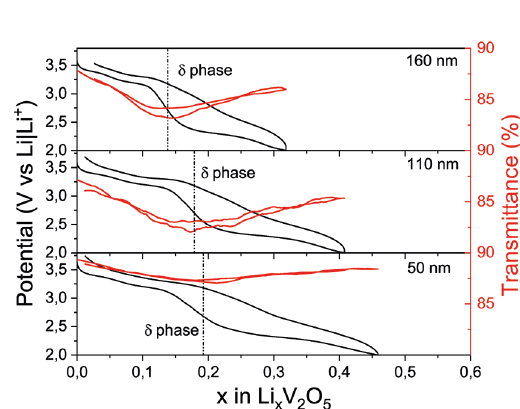
Figure 9. Transmittance as a function of wavelength during the ionic intercalation process (Inset: Transmittance as a function of potential showing regions of optical absorption for blue light (400 nm) and red light (632